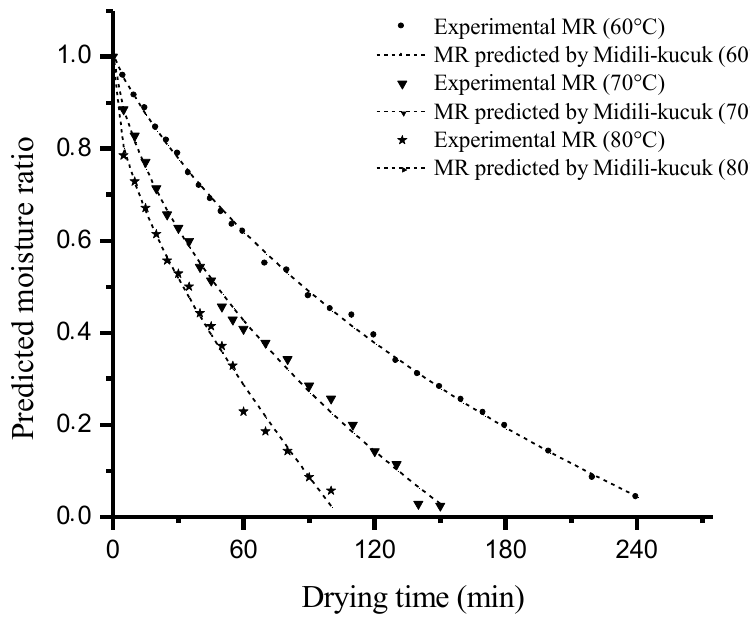
Figure 4. Experimental drying data of moisture ratio versus drying time as fitted with Midilli ‐ Kucuk model.